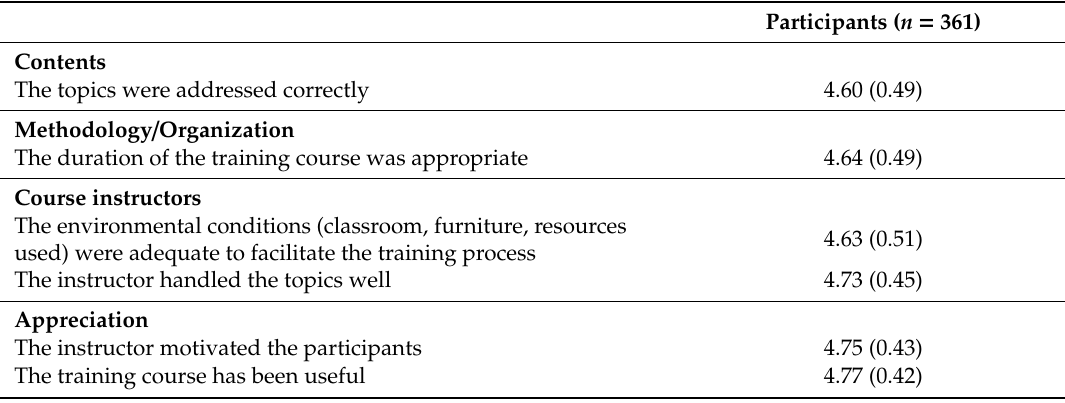
Table 3. Training course satisfaction questionnaire.